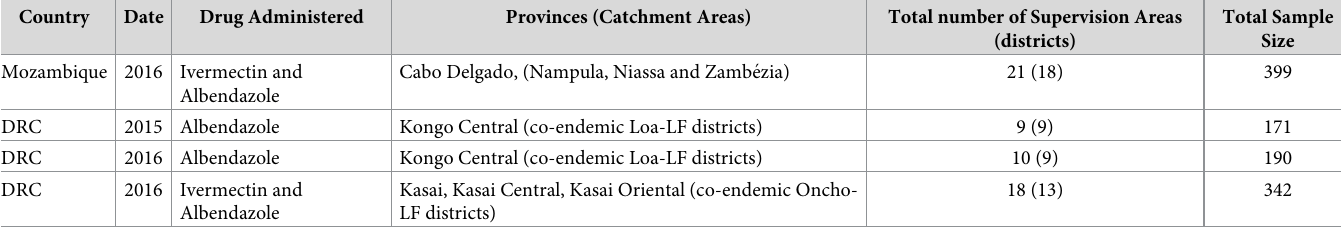
Table 1. Study characteristics in Mozambique and DRC for